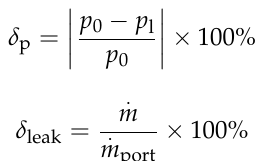
Figure 18. Pressure distribution in the passage at 0.16 ms for the case of gap width of 0.8 mm, pressure ratio of 1.5.